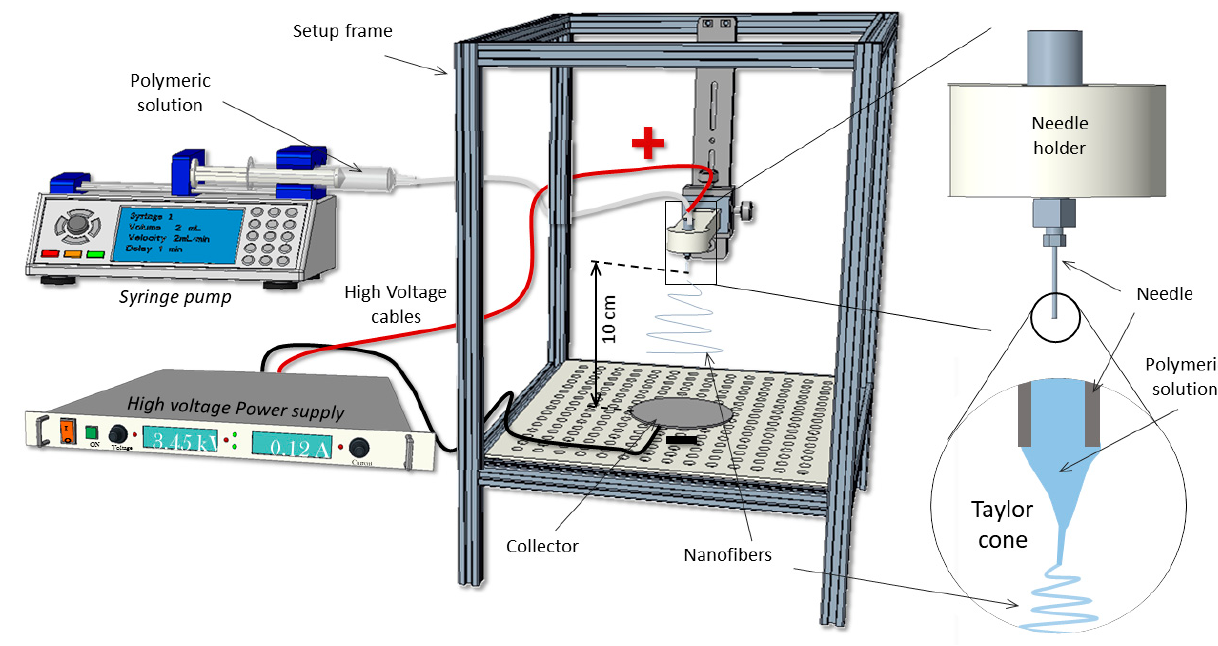
Figure 1. Home-made electrospinning setup.